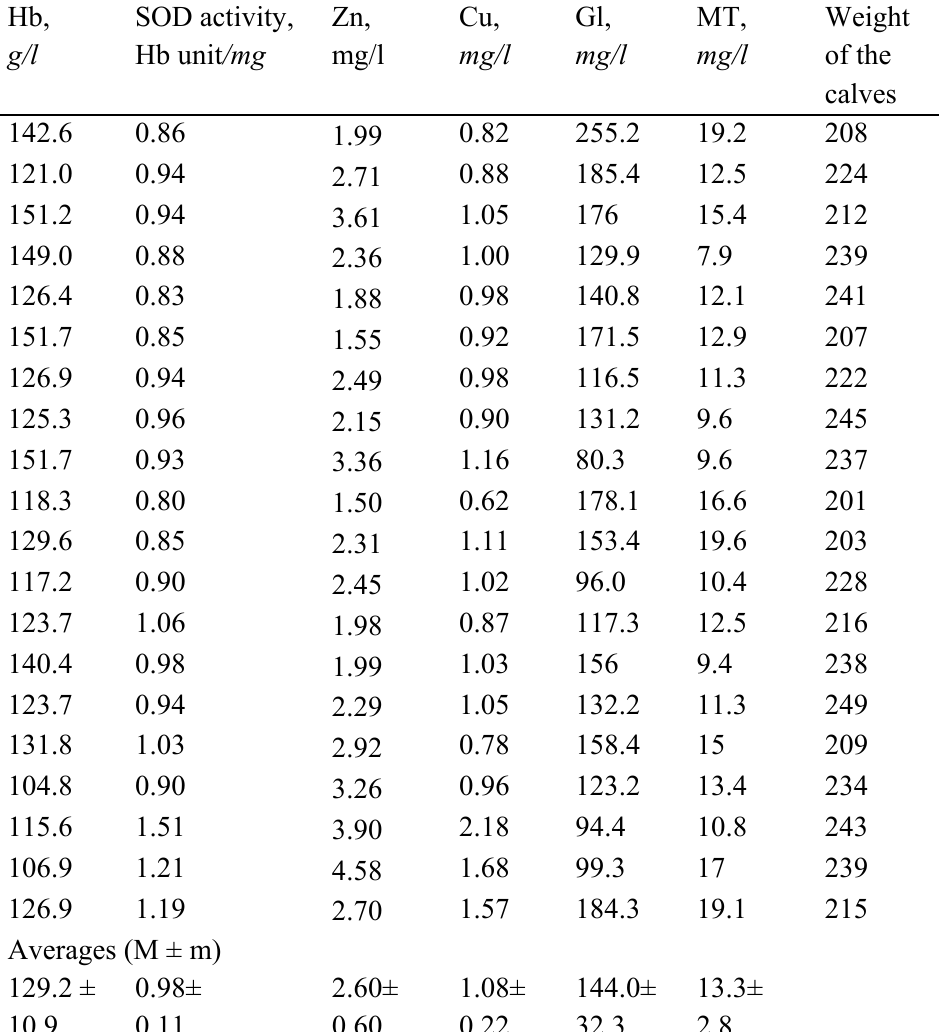
H EMOGLOBIN , ZINC , COPPER , GLUTATHIONE , AND METALLOTHIONEINS CONTENT AND SOD ACTIVITY IN THE CALVES